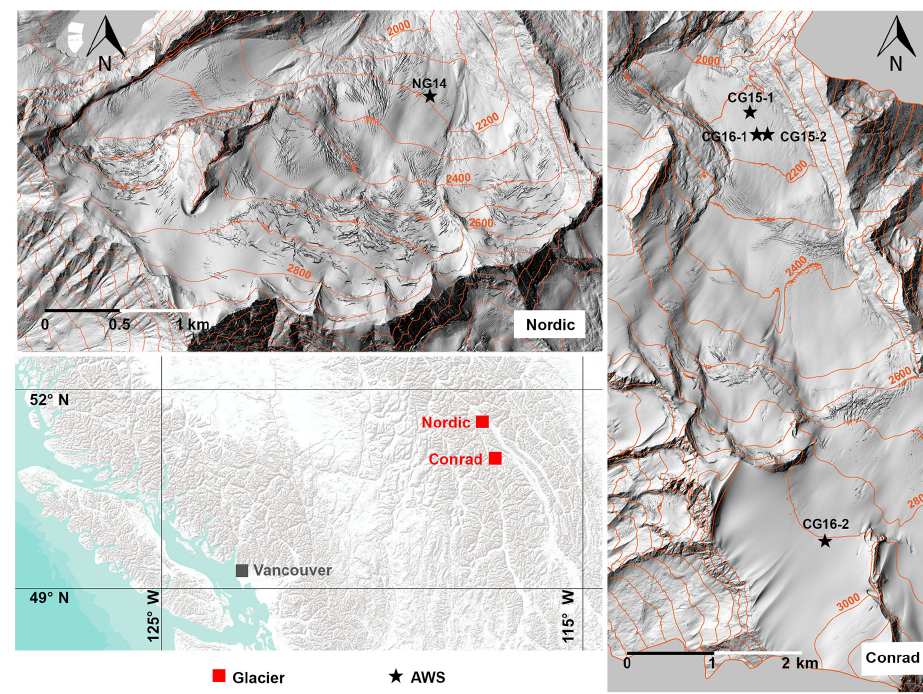
Figure 1. Location of the study glaciers and the stations installed during the 2014–2016 melt seasons. Table 1. Locations and dates of operation of the automatic weather stations used in this study. Station NG14 CG15-1 CG15-2 CG16-1 CG16-2 Glacier Nordic Conrad Conrad Conrad Conrad Location ablation ablation ablation ablation